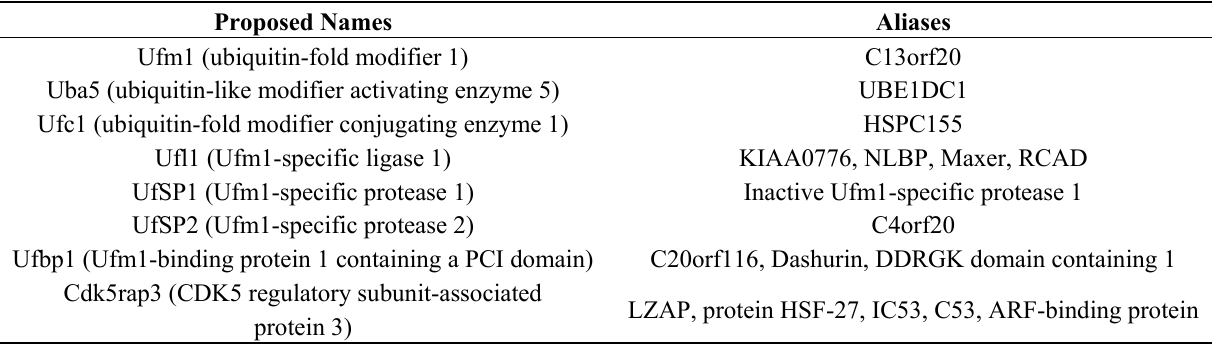
Table 1. Proposed names of the Ufm1 system and their